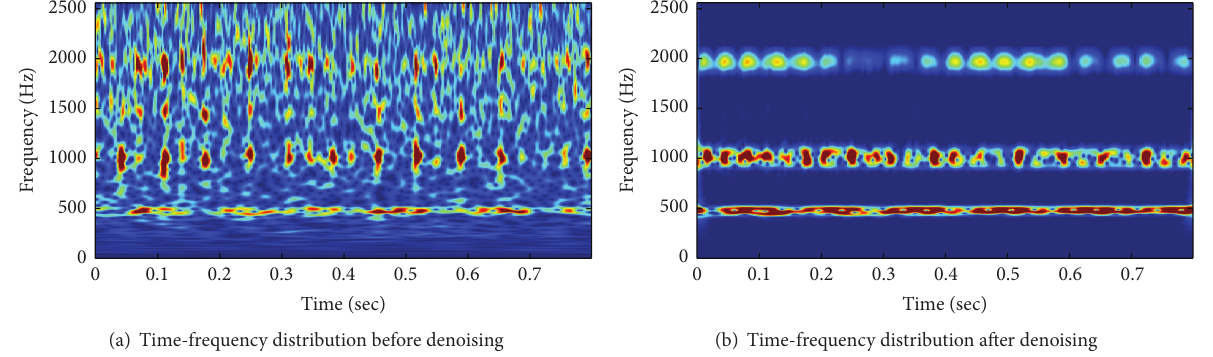
Figure 15: Time-frequency distribution of the vibration signal.